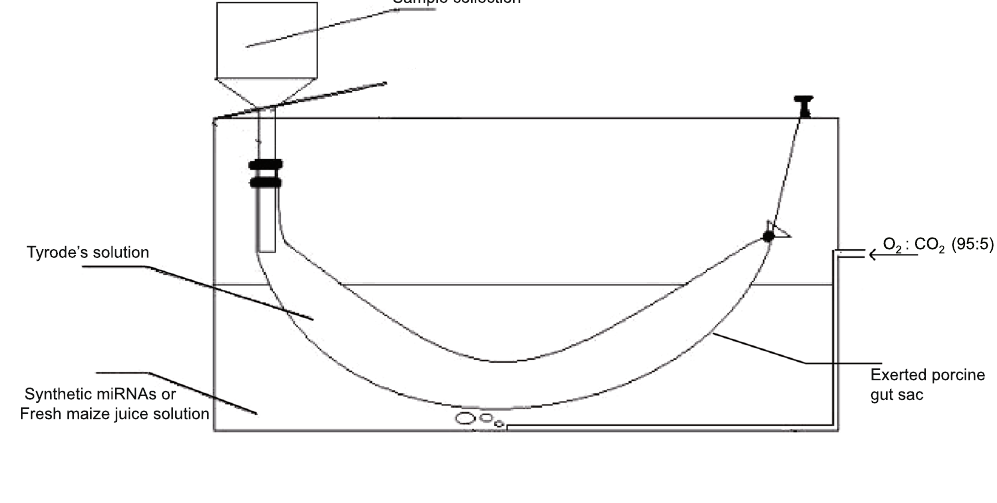
4 Scientific RepoRts | 7: 645 | DOI:10.1038/s41598-017-00488-y